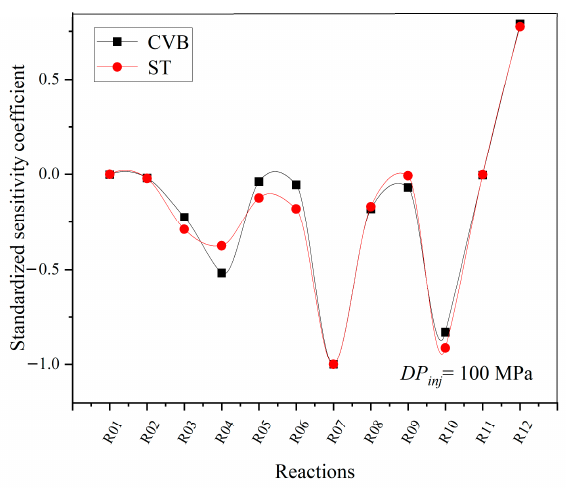
Figure 7. Normalized sensitivity coefficient for CVBs versus shock tubes (initial temperature of 800 K for shock tubes; ambient temperature of 850 K for CVB).